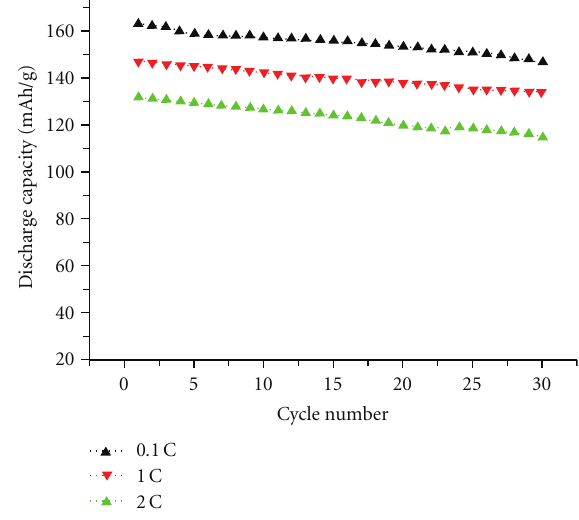
Figure 6: The discharge capacity versus cycle number plot for the LiFePO 4 /CNT electrode, at di ff erent